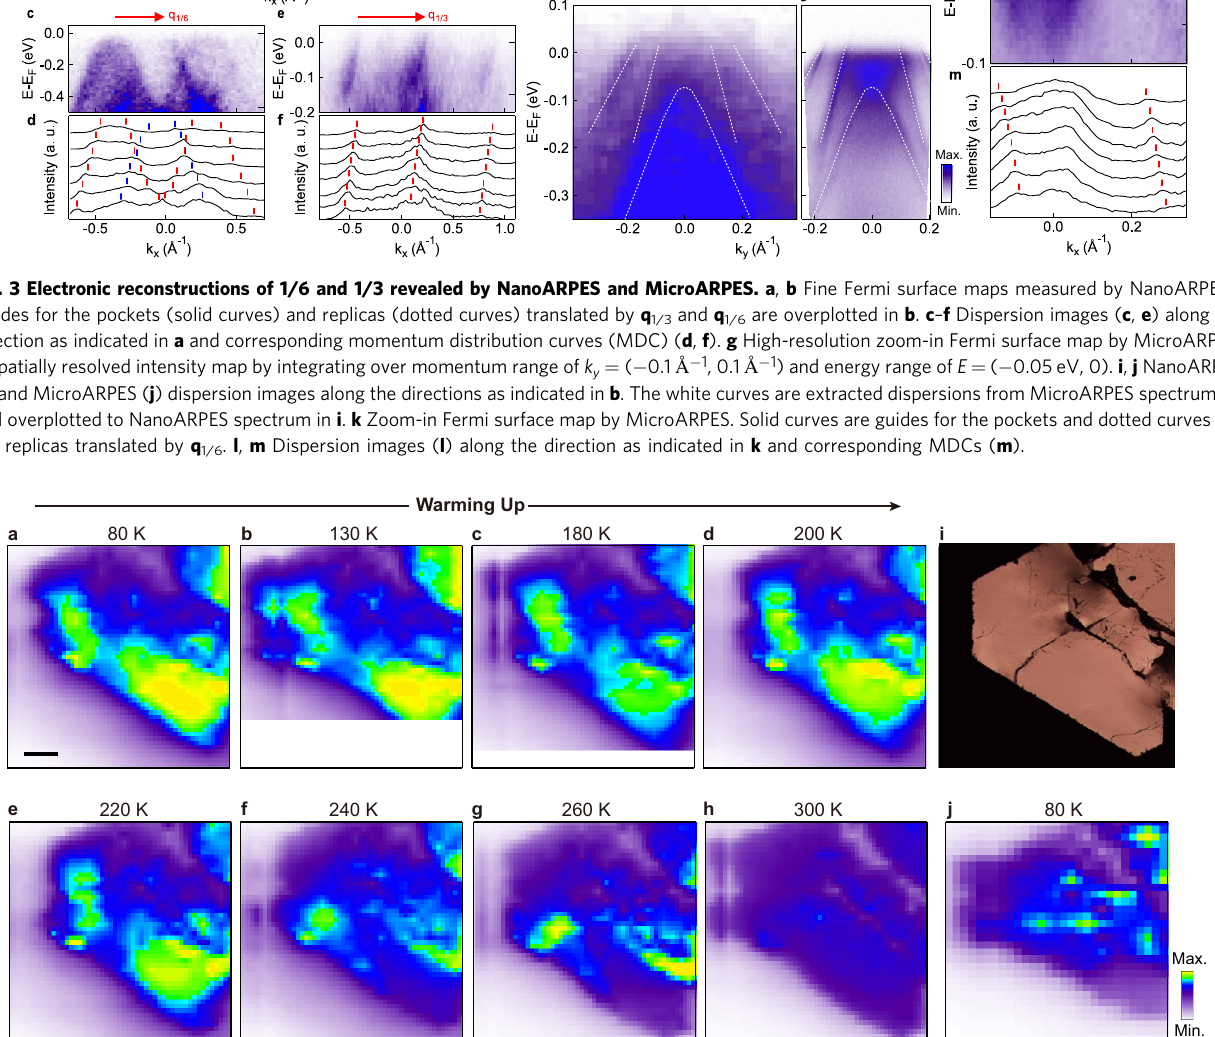
Fig. 4 Spatially resolved MicroARPES intensity maps reveal the temperature dependence of the separated domains measured with laser source at photon energy of 6.2 eV. a – h The evolution of spatially resolved MicroARPES intensity maps upon warming by integrating over momentum range of k y = ( − 0.1 Å − 1 , 0.1 Å − 1 ) and energy range of E = ( − 0.05 eV, 0). The scale bar is 200 μ m. i Optical image of the sample. j Spatially resolved MicroARPES intensity map at 80 K after cooling